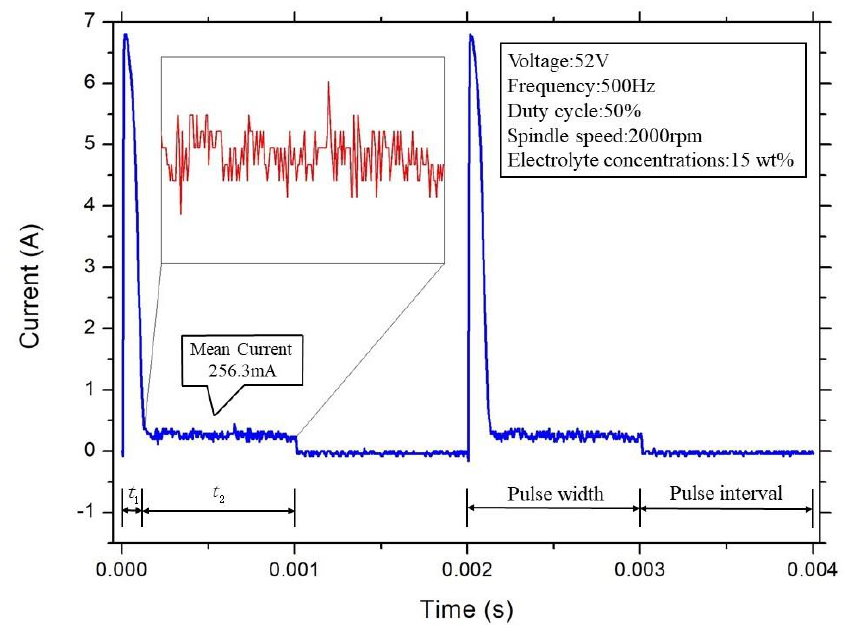
Figure 3. SEM image of the tool electrode under different experimental parameters.